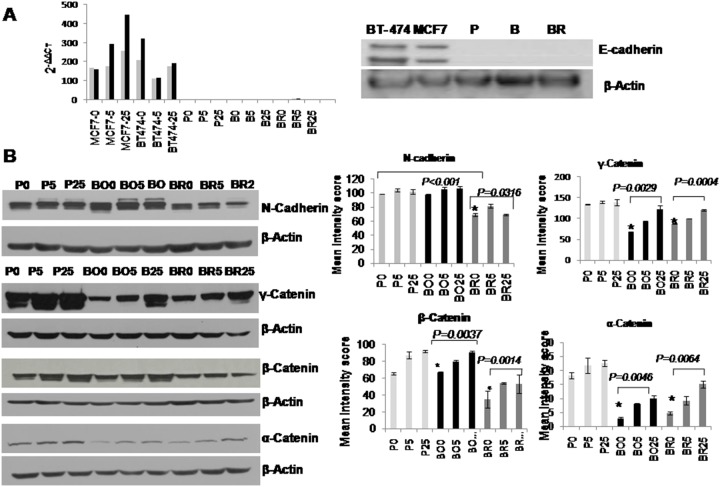
Expression of E-Cadherin, N-Cadherin, γ, β and α-Catenins in response to glucose for 24
hrs. (A) The graph (left) shows real time PCR results for the positive expression of E-cadherin in MCF-7 and BT-474 cell lines; the grey and black bars represent two repeated independent experiments. However, MDA-MB-231P and its two variant cell lines did not express detectable E-cadherin message or protein (right); (B) Representative blots (left) and quantification (right) shows that MDA-MB-231P and MDA-MB-231BO cells expressed higher levels of N-cadherin compared with the MDA-MB-231BR cells, and that N-cadherin in the former cells was significantly reduced under hypoglycemia. γ, β and α-Catenins were all reduced under hypoglycemic conditions and their expression was significantly decreased in the two MDA-MB-231 variant cells only. Error bars represent ± standard deviation. Note: β-Actin was used in all the blots as a protein loading control.